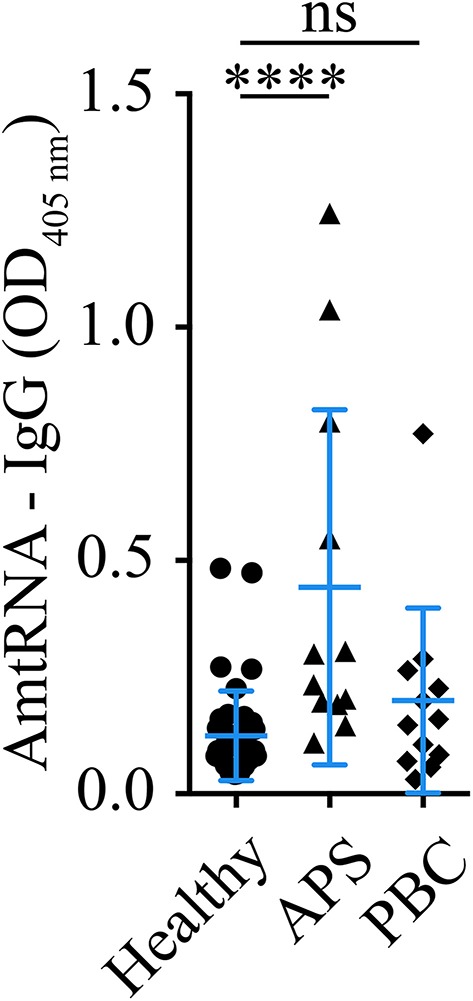
Detection of AmtRNA in two different diseases with anti-mitochondrial antibodies. Antiphospholipid syndrome (APS) and primary biliary cirrhosis (PBS) are two diseases with antibodies targeting mitochondrial antigens; cardiolipin (M1) in APS and PDC-E2 (M2), sulfite oxidase (M4), M8 (whose target is still unclear) and sarcosine dehydrogenase (M9) in PBC. Sera (1:150) from patients with APS presented a significant increase in circulating autoantibodies against mtRNA, compared to healthy individuals, whereas PBC patients had levels similar to the controls. Healthy: N = 43, APS: N = 12, PBC N = 12. Data are Mean ± SD. Kruskal-Wallis test with multiple comparisons to controls/healthy donors; Dunn's correction. ****p < 0.001.